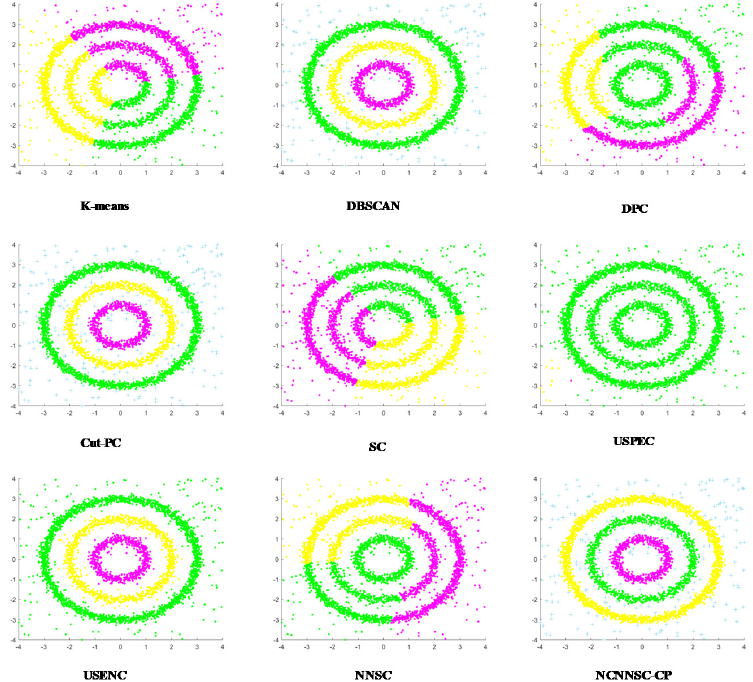
Figure 9. The results of 9 clustering algorithms in D4.